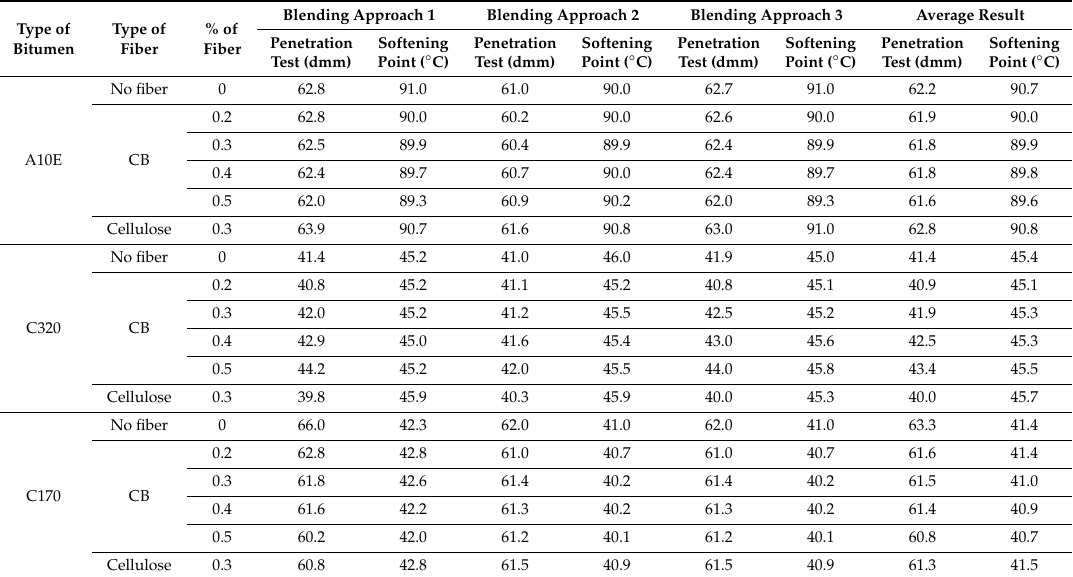
Table 5. Penetration and softening point